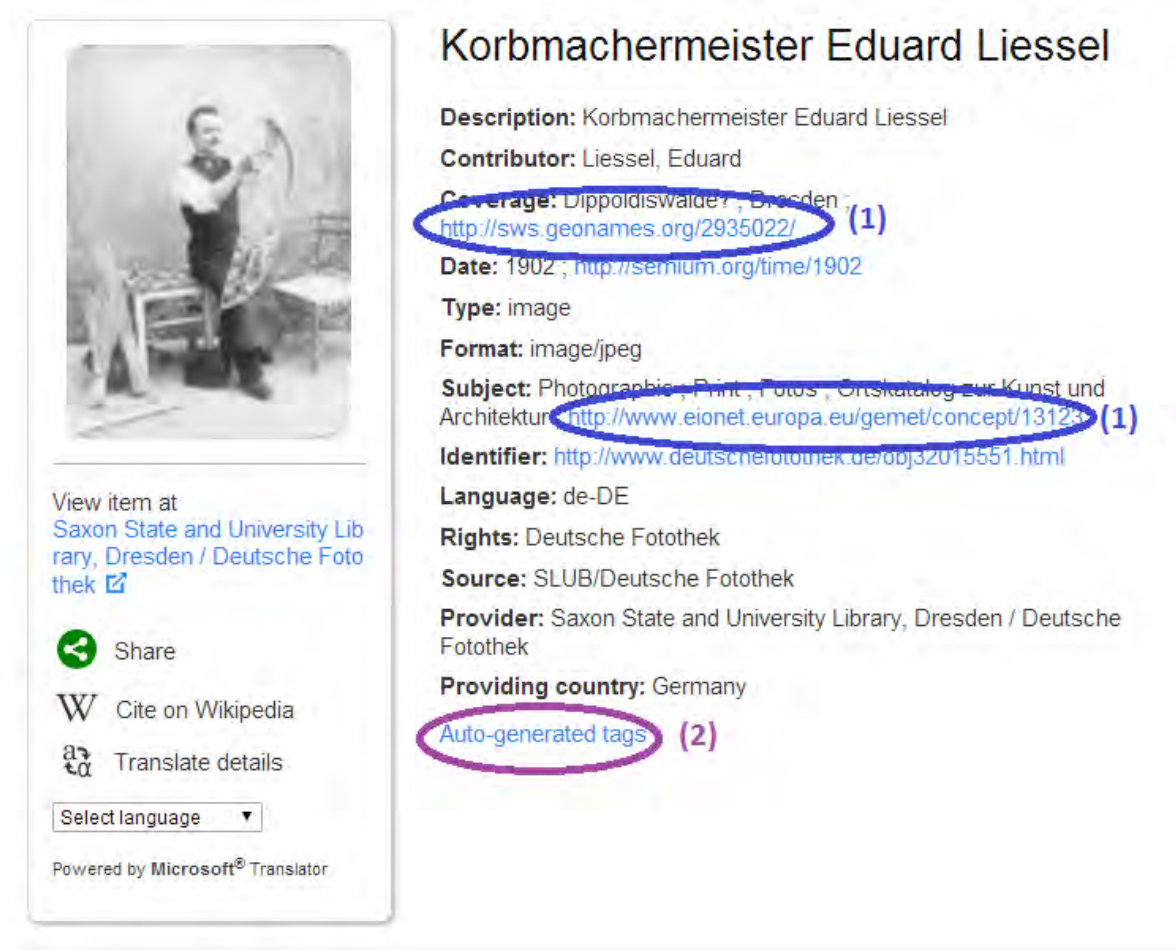
Fig 4: Links to vocabulary resources shown in object